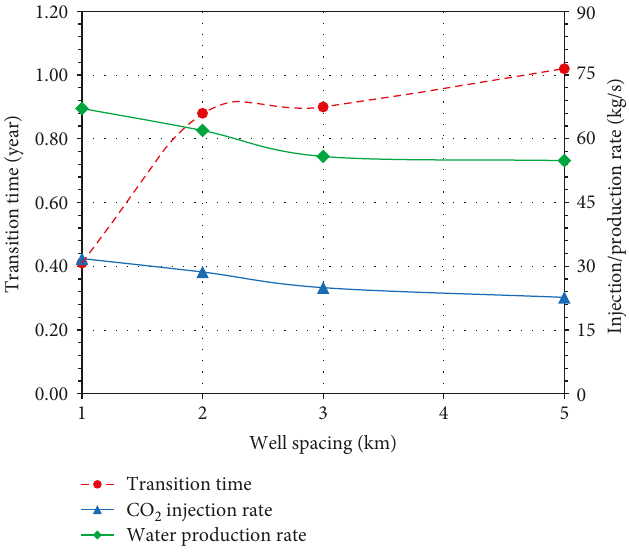
Figure 14: In fl uence of the well spacing on the transition time point, injection rate, and production